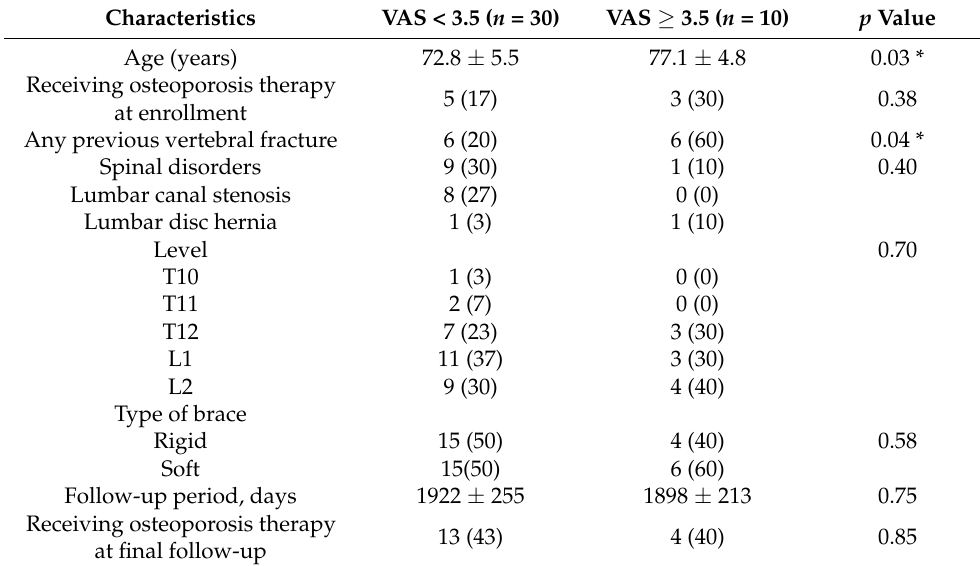
Table 1. Baseline characteristics of the